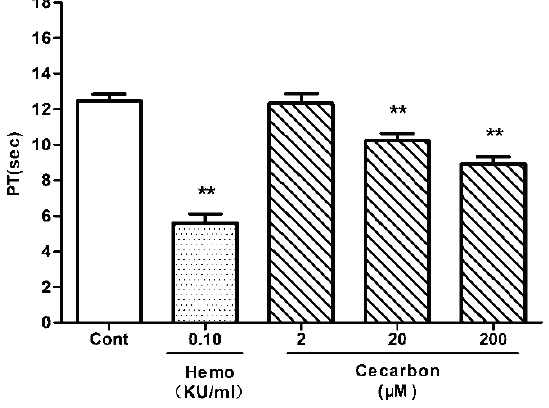
Figure 6. Effect of cecarbon on New Zealand rabbit plasma PT. Data were expressed as mean ± SD ( n = 6). The p -values shown were calculated by using non-parametric repeated measures ANOVA (Friedman test) (** p < 0.01).